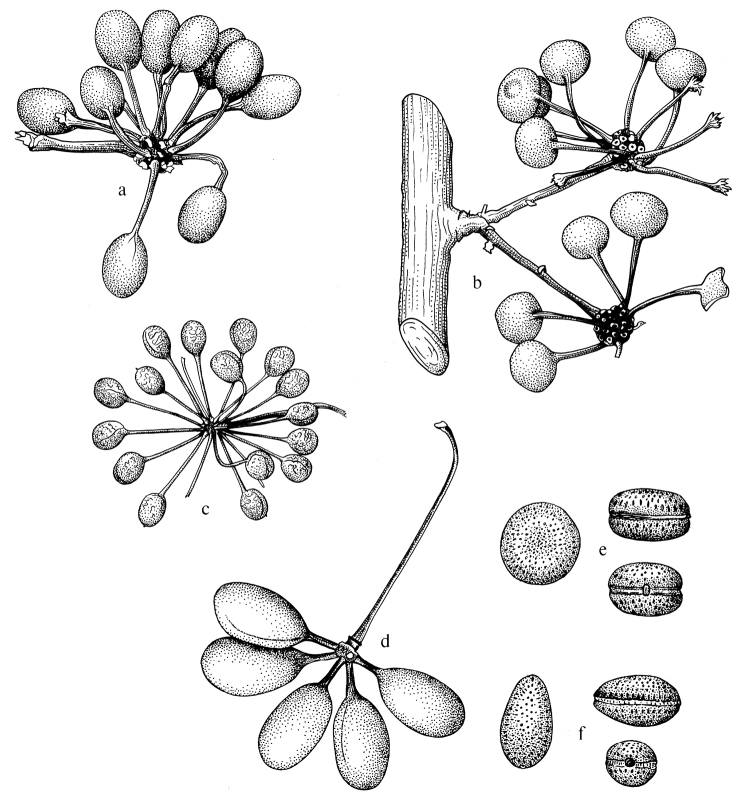
Fruits and seeds of Cremastosperma. Adapted from plate 8 from van Setten & Koek-Noorman (1992). aCremastospermamegalophyllum R.E.Fr. b, eC.cauliflorum R.E.Fr. cC.microcarpum R.E.Fr. dC.macrocarpum Maas fC.monospermum (Rusby) R.E.Fr. (aBrandbyge & Asanza C. 30017b, ePrance et al. 24094cGentry et al. 32153dWingfield & van der Werff 6751fSperling et al. 6198).